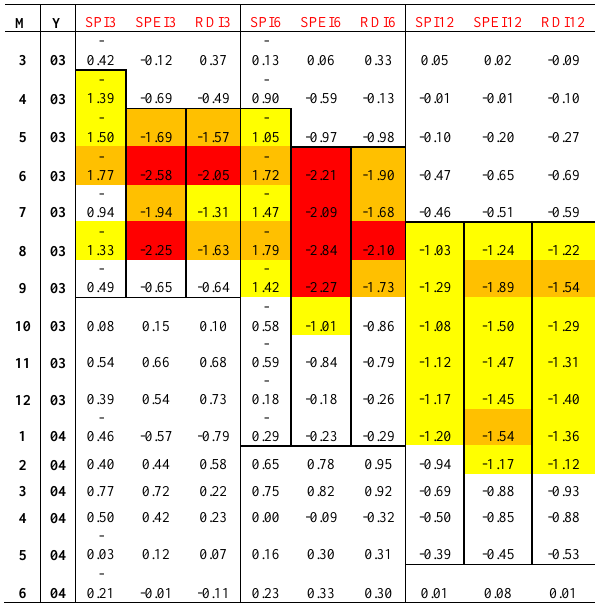
Table 6. The drought that followed the summer heat wave of 2003 as seen by for SPI, SPEI, and RDI. The bold boundaries enclose the drought